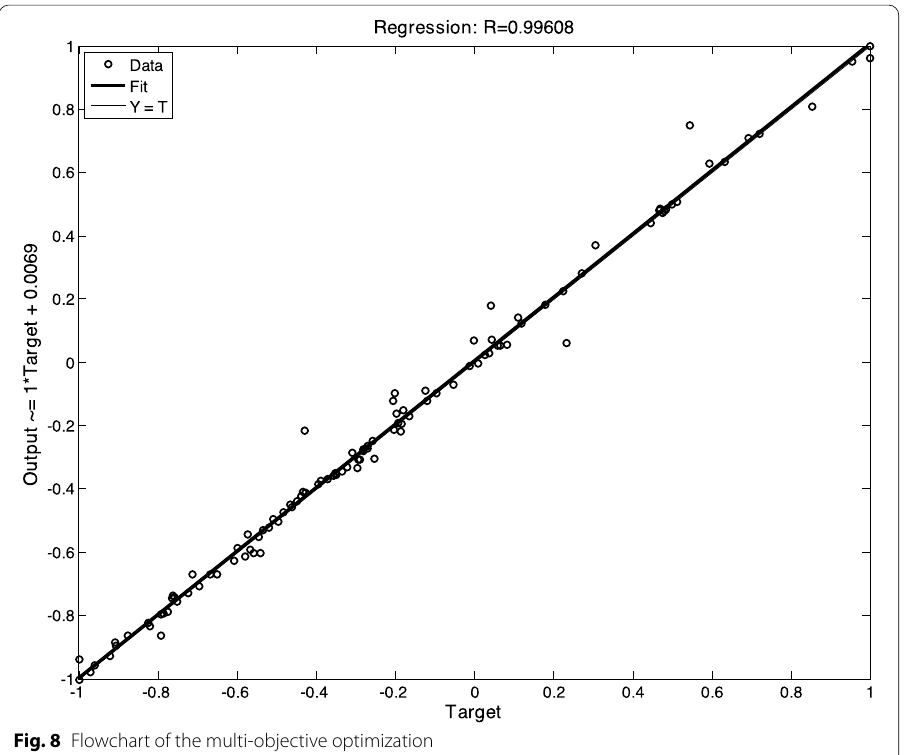
Fig. 8 Flowchart of the multi-objective optimization